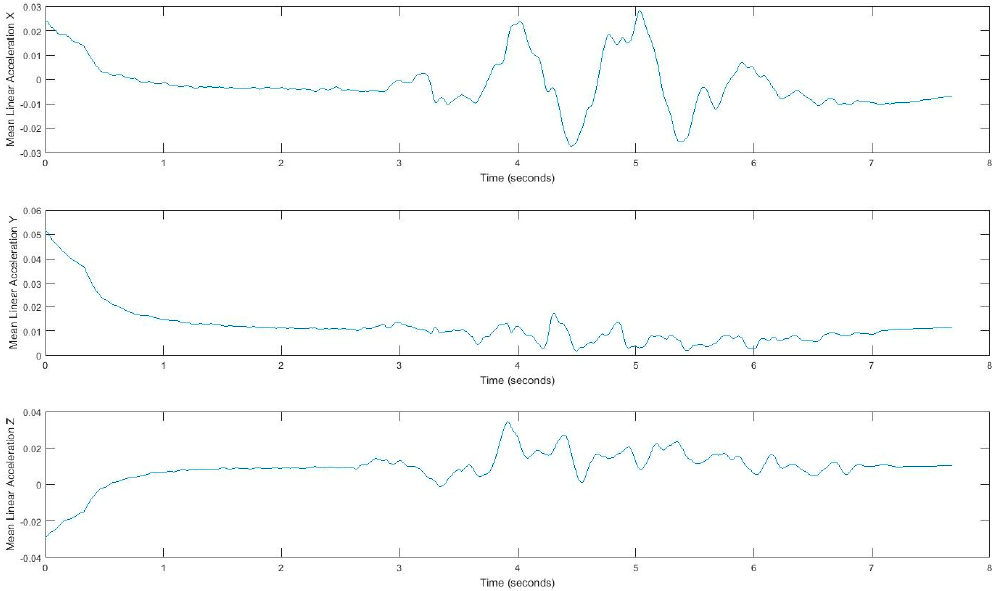
Figure 5. Mean of linear acceleration, using a sliding window.